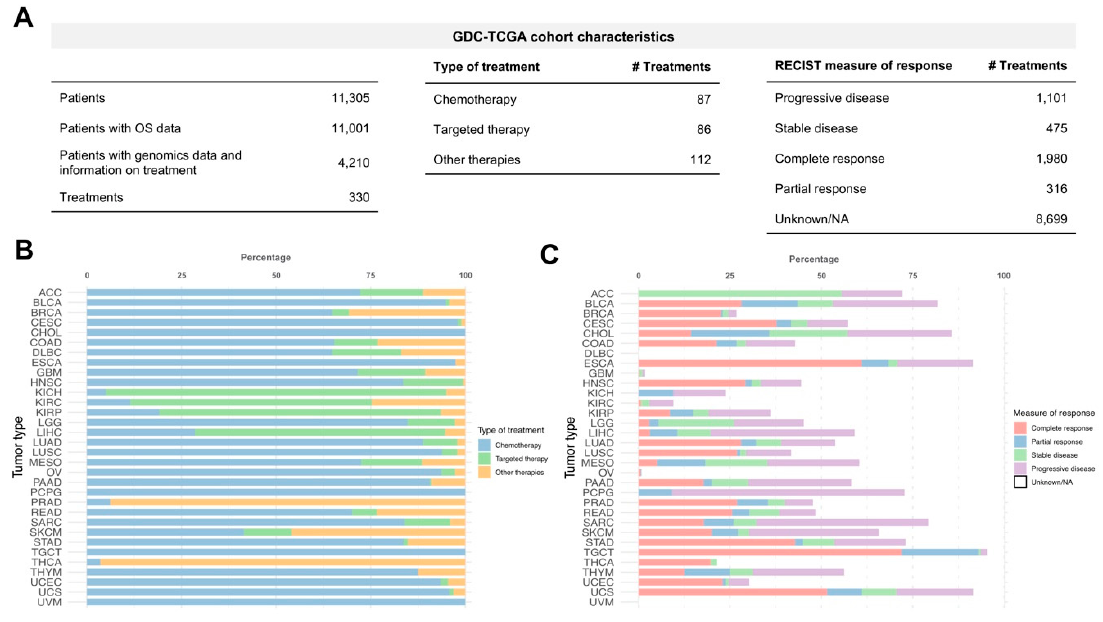
Figure 1 . Genomic Data Commons effort and The Cancer Genome Atlas (GDC-TCGA) cohort description. ( A ) Tables showing total number of patients and drugs administered, type of treatments received and Response Evaluation Criteria in Solid Tumours (RECIST) measure of response in GDC-TCGA cohort. ( B ) Percentage of treatments received by tumour type. Bar colour represents the type of anticancer therapy (targeted therapy, chemotherapy and other therapies such as hormone therapy, immunotherapy and ancillary therapies). ( C ) Percentage of treatments with measure of response by tumour type. Bar colour represents the different measures of response following the RECIST guidelines.